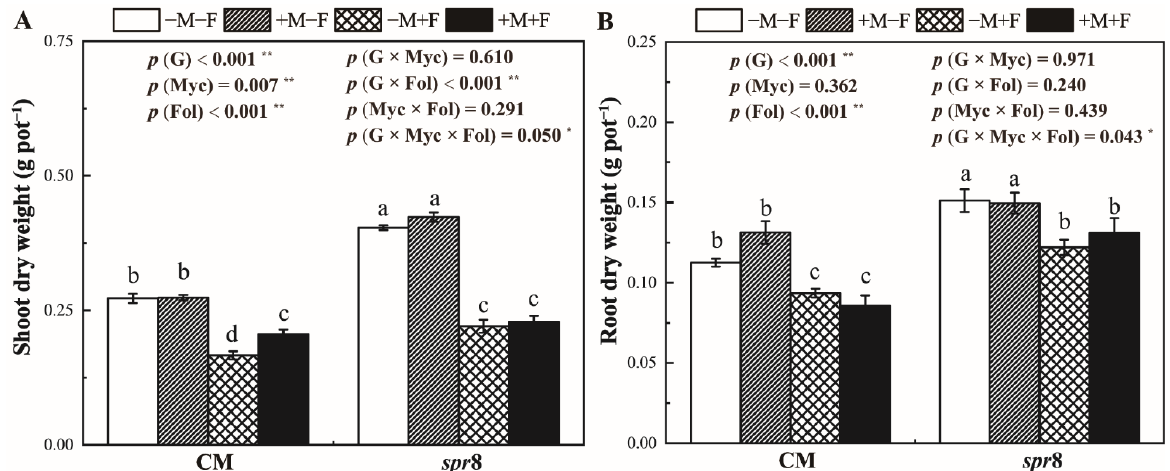
Figure 2. Effects of inoculation with Rhizophagus irregularis inoculation (Myc) and Fusarium oxysporum f. sp. Lycopersici (Fol) on the shoot ( A ) and root ( B ) dry weight of tomato CM and spr8 plants (G). − M and +M represent non-inoculation and inoculation with Rhizophagus irregularis , respectively. − F and +F represent non-inoculation and inoculation with Fusarium oxysporum f. sp. Lycopersici , respectively. Same lowercase letters above the columns indicate non-significant difference ( p < 0.05) between corresponding treatments. *— p < 0.05; **— p < 0.01.